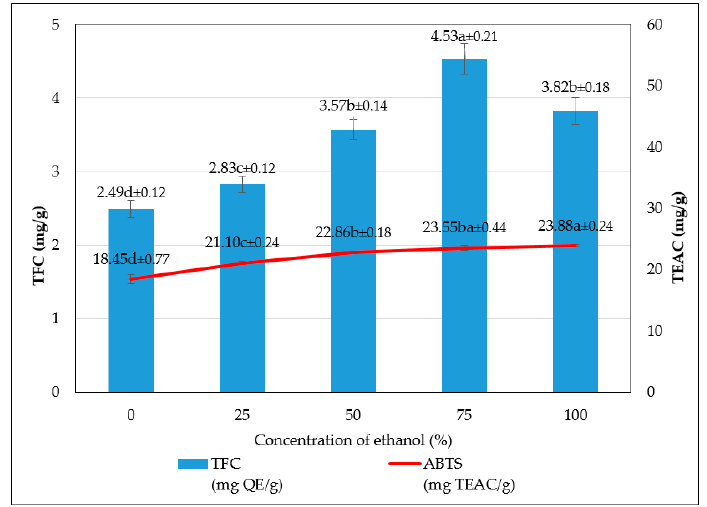
Figure 3. The effect of ethanol concentration on the total flavonoid content (TFC) and Trolox Figure 3. The e ff ect of ethanol concentration on the total flavonoid content (TFC) and Trolox equivalent equivalent antioxidant capacity (TEAC) on WRE. antioxidant capacity (TEAC) on